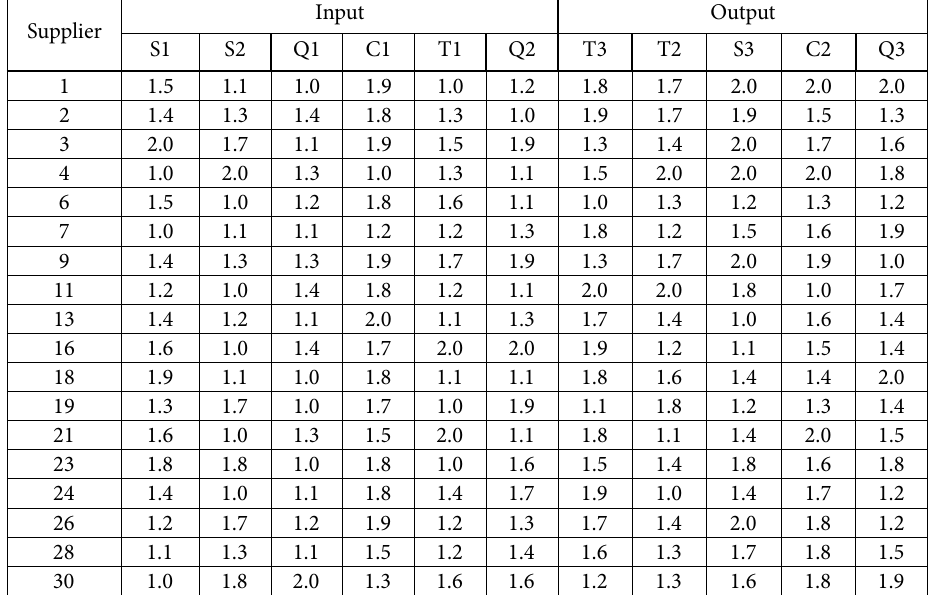
Table 8. Processed data of intake air pressure sensor for the DEA